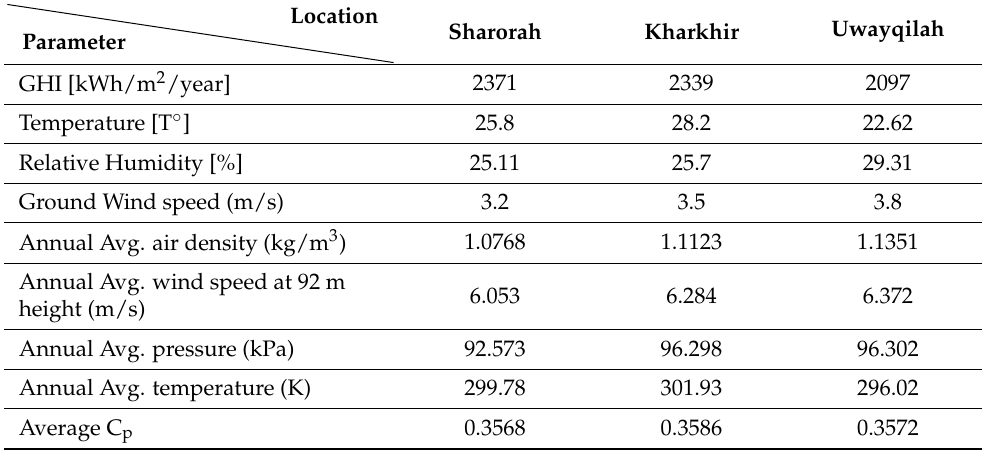
Table 3. Solar and wind resources and climate conditions in isolated areas observed in 2016.